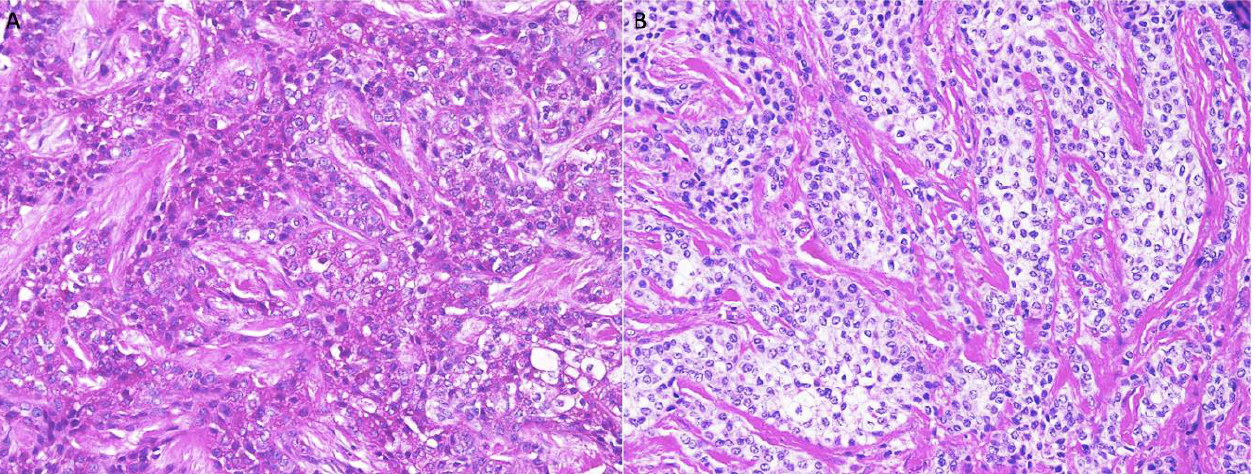
Figure 4. Immunohistochemical staining showing PAS-positive ( A ) and diastase-labile intracyto- plasmic glycogen ( B ) (200×).